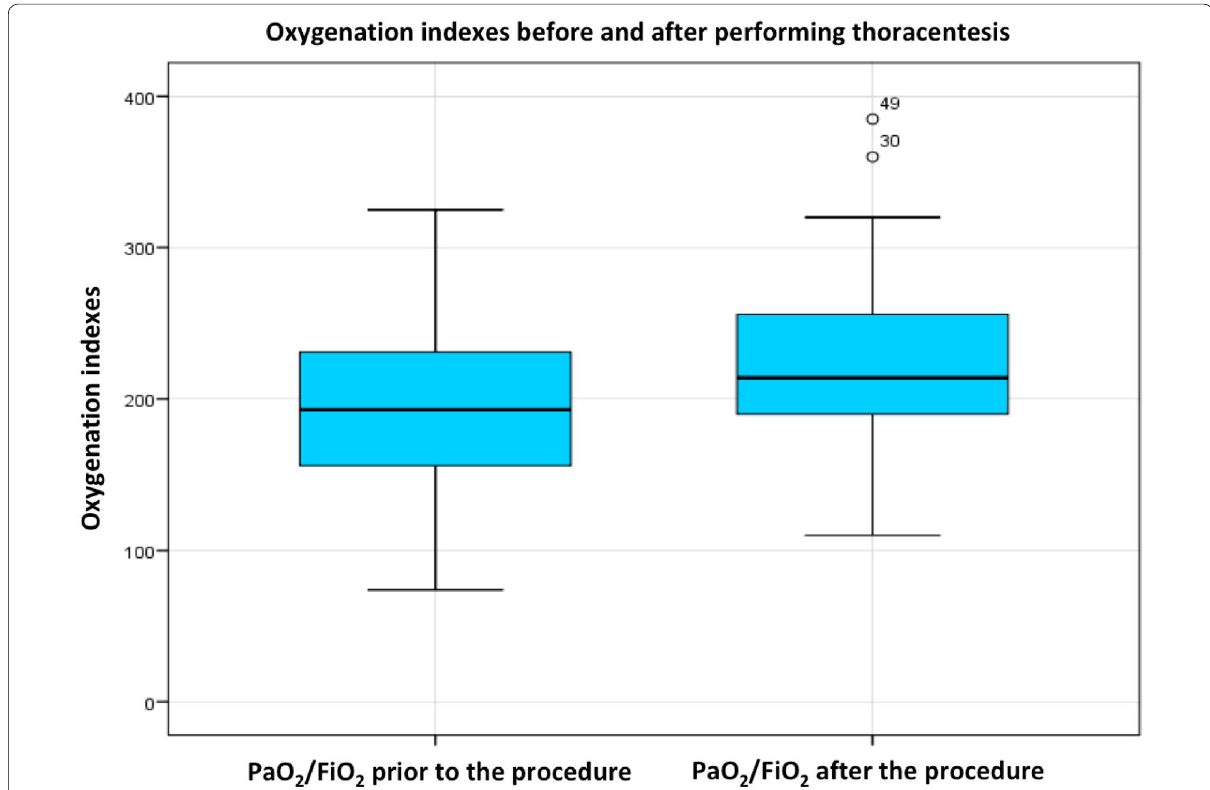
Fig. 4 Oxygenation indexes before and after performing thoracentesis. The average PaO 2 /FiO 2 before the procedure was 198.1, and the average PaO 2 /FiO 2 after the procedure was 224.6, p < 0.05